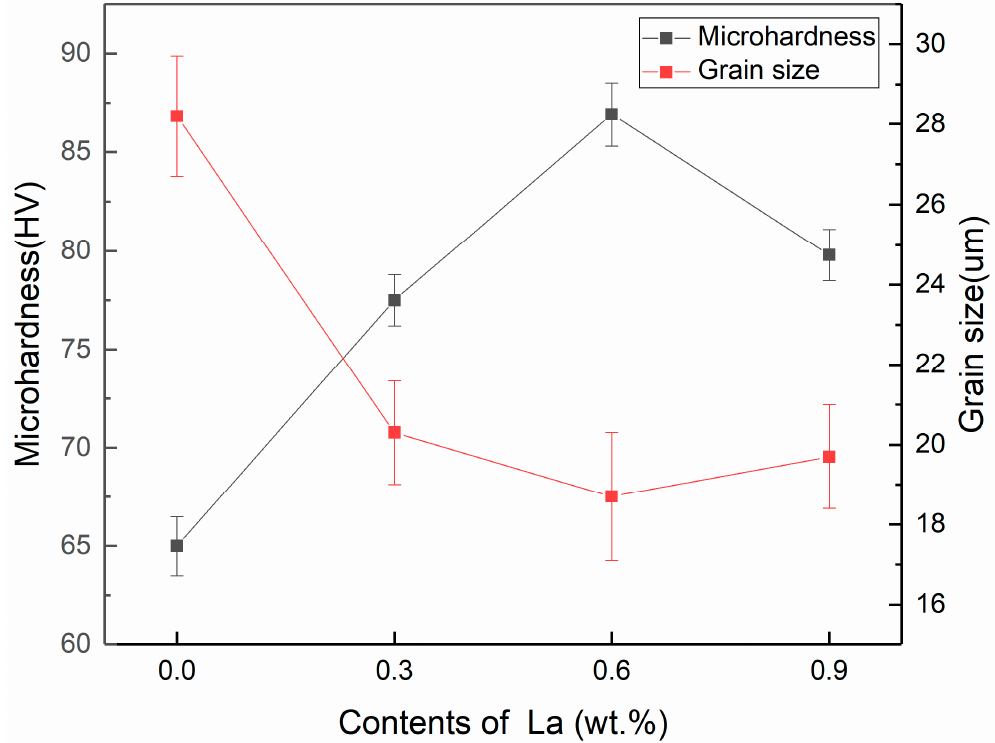
Figure 4. Microhardness and grain size of AlSi5Cu1Mg alloys with different contents La.